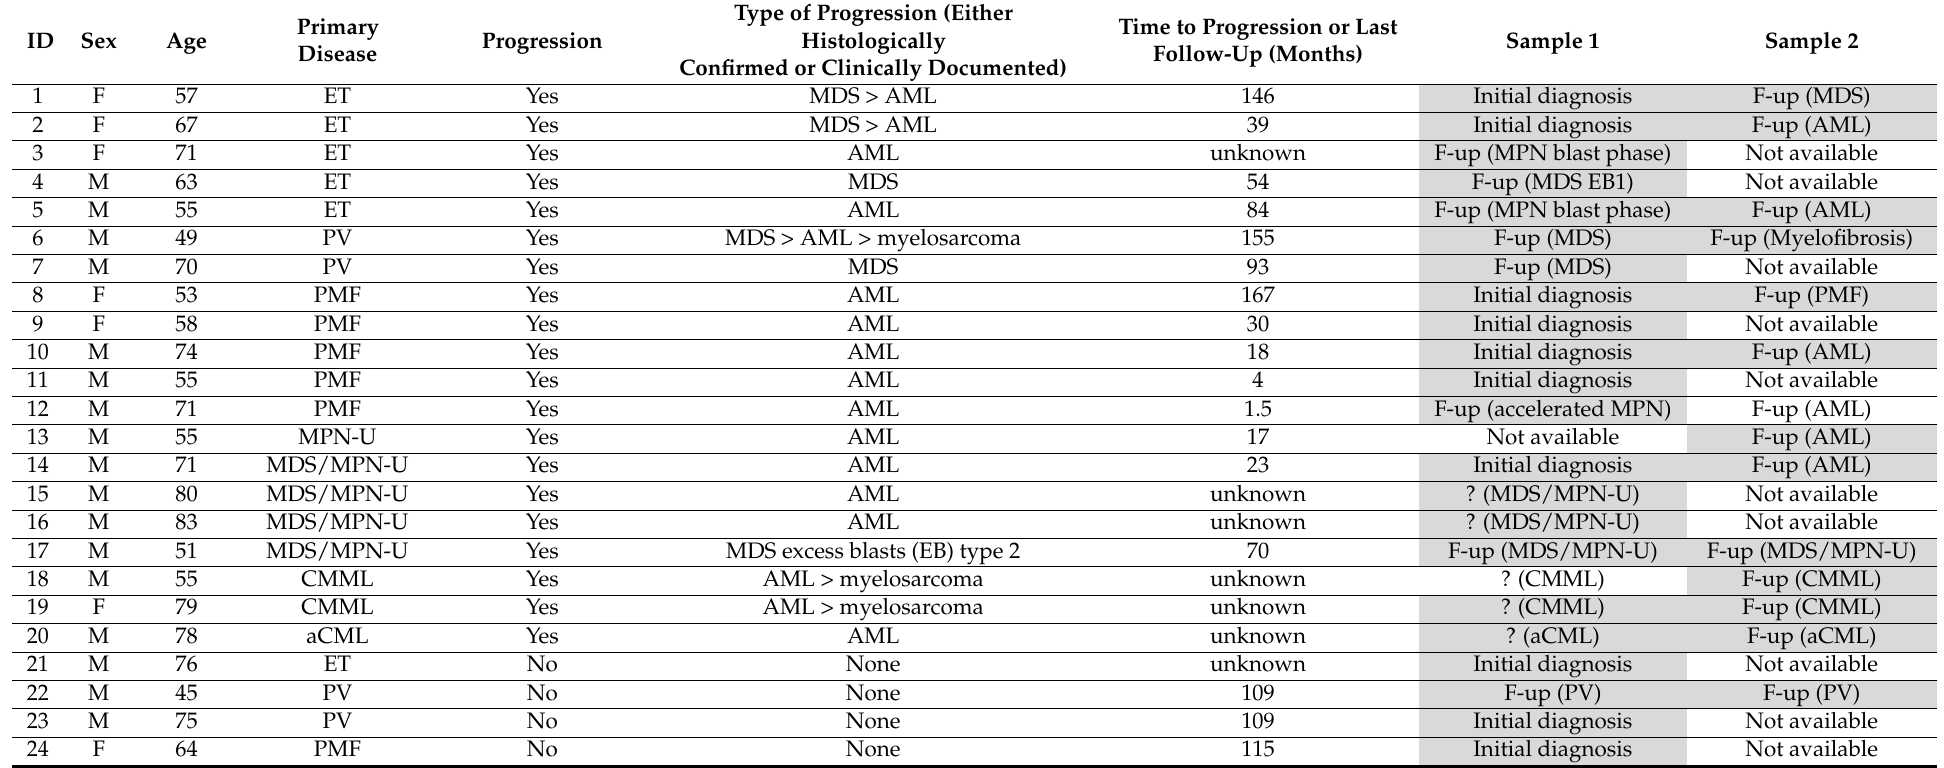
Table 1. Patient characteristics. Abbreviations: aCML, atypical chronic myeloid leukemia; AML, acute myeloid leukemia; CMML, chronic myelomonocytic leukemia; ET, essential thrombocythemia; F-up, follow-up; MDS, myelodysplastic syndrome; MPN, myeloproliferative neoplasm; PMF, primary myelofibrosis; PV, polycythemia vera; U, unclassified. “Sample 1” describes the first available biopsy, which was either gained at the time point of “Initial diagnosis” or later in disease course (“F-up”). It was used to assess baseline molecular characteristics or, in cases with only an available biopsy at progression, to assess the mutational landscape of the respective progressed disease. Cases from which we did not know, whether it was